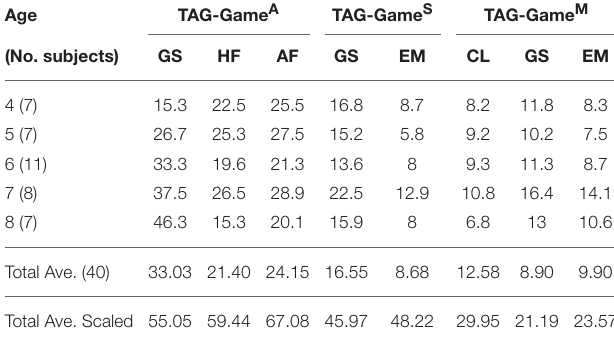
The number inside the parenthesis indicates the total available raw score for each game. The bottom row shows the total average scores transformed to 0–100 scale for ease of